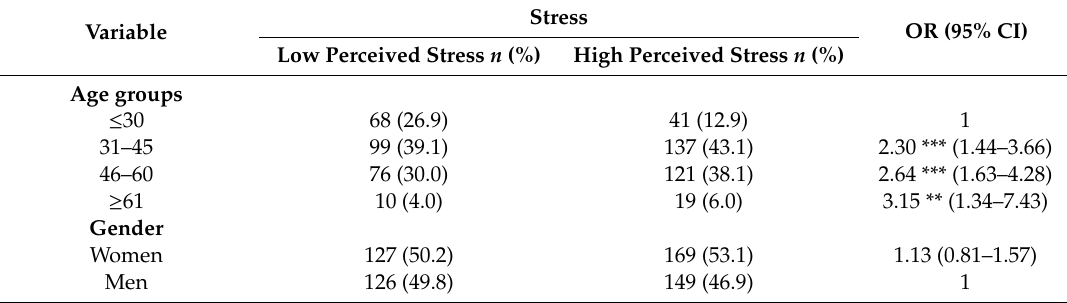
Table 2. The relationship between the potential risk factors and perceived stress